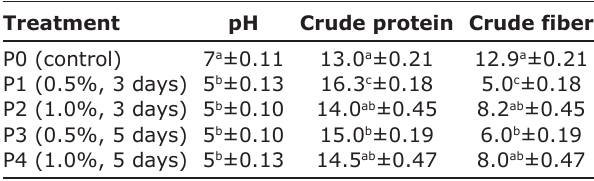
Table-6: Analysis result on nutrient content changes in wheat pollard fermentation using L. casei WPL 315 isolate